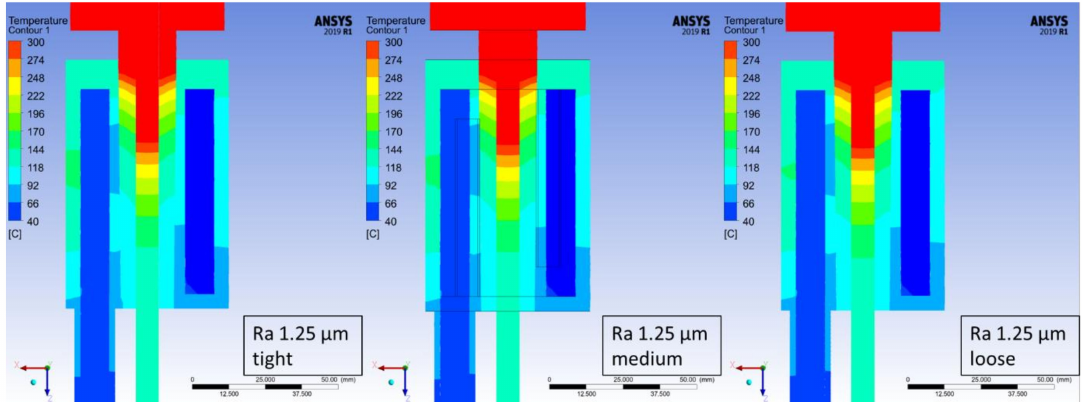
Figure 8. Continuous casting process simulation for the crystallizer with Ra 1.25 μm and tight fit with the cooling system ( left ), medium fit with the cooling system ( middle ) and loose fit with the cooling system ( right ); step 900 of the simulations (450 s).